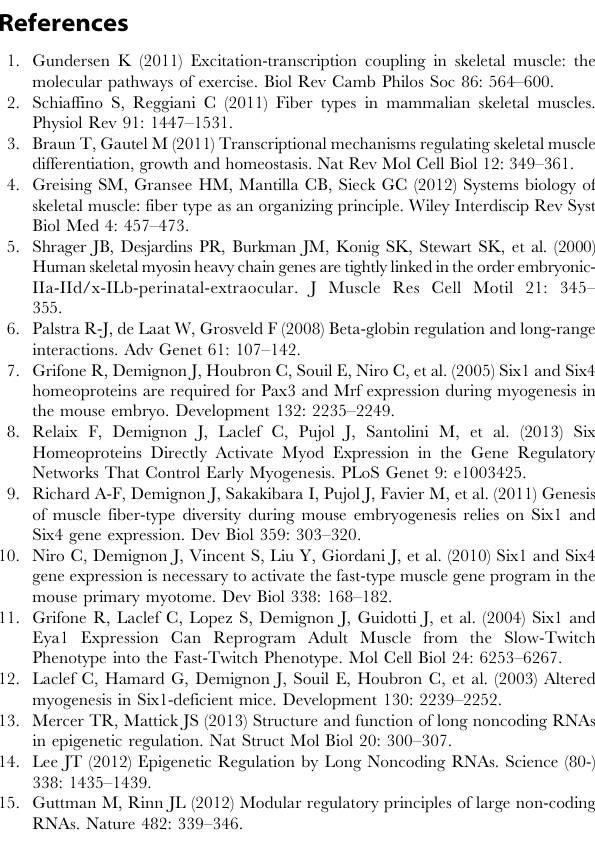
Table S2 Microarrays analysis of GP muscles of cSix1. Table S3 Sequence of the oligonucleotides used for 3C. Table S4 Sequence of the oligonucleotides used for qPCR. Table S5 Coordinates (mm9) of the fragments used to learn the MEF3 PWM. Table S6 MEF3 frequency